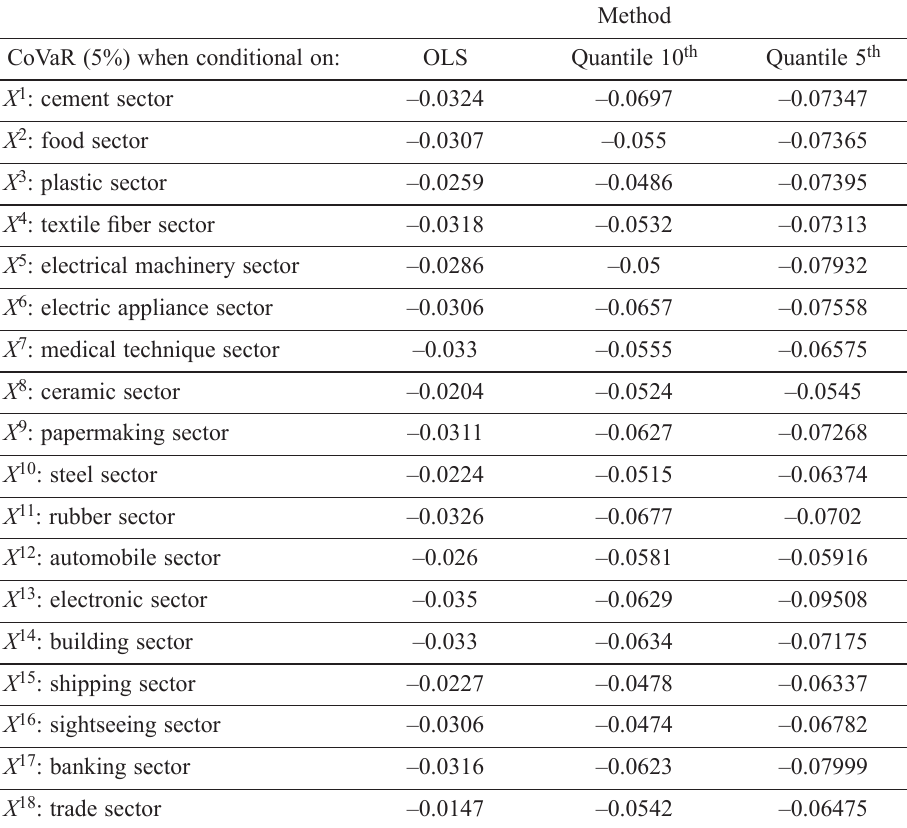
Table 3. Predicted CoVaR(5%) of Taiwan stock sector index using OLS, Quantile 5% and Quantile 10%